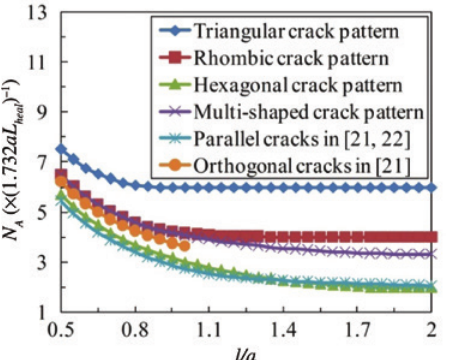
Figure 11: Verification of crack-hitting probability models for the multi-shaped crack pattern.